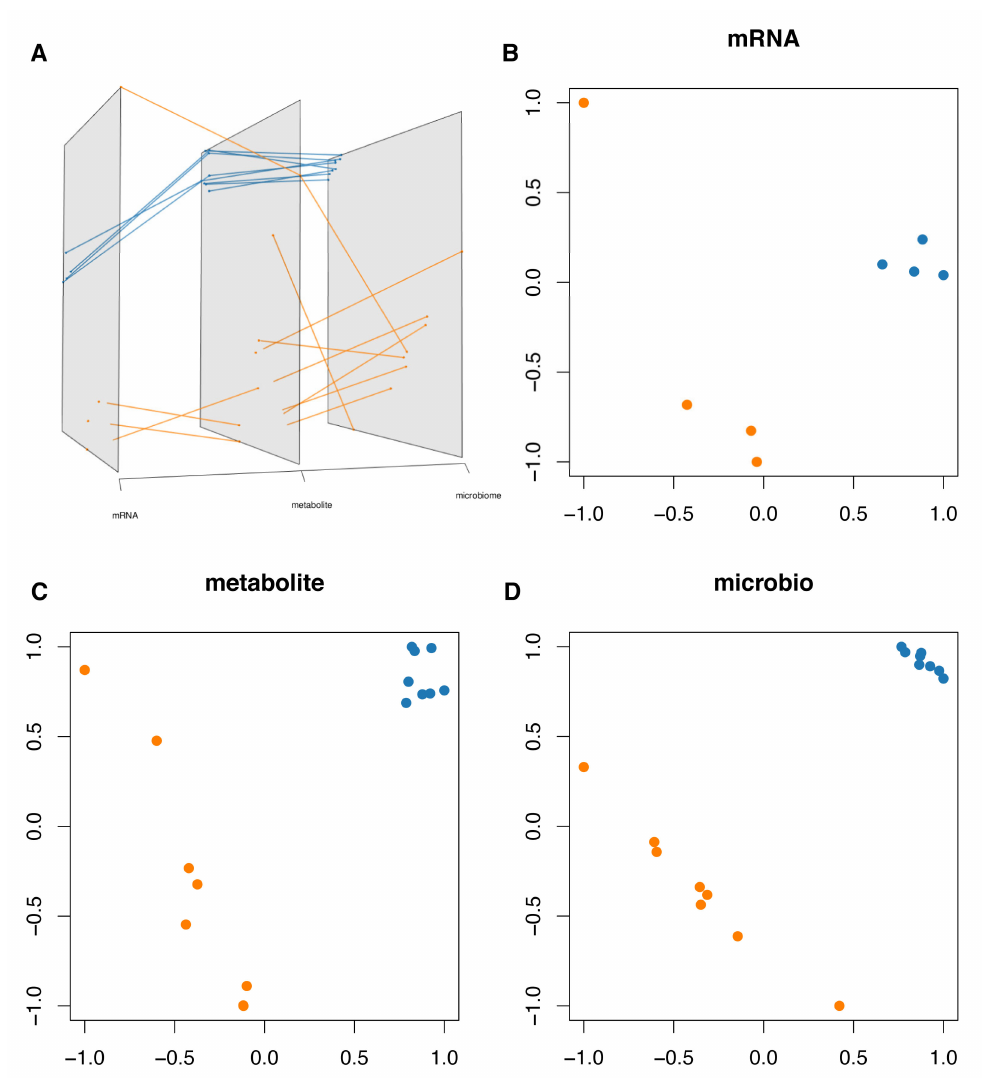
Figure 9. PLS-DA for multi-omics data. ( A ) Grimon visualization for multi-omics data. Each plane represents a two-dimensional visualization of the Partial least squares discriminant analysis (PLS-DA) result of each omics data. The same sample in different planes was connected. ( B – D ) Two- dimensional projections of PLS-DA results in each grimon plane. The color represents the group of each